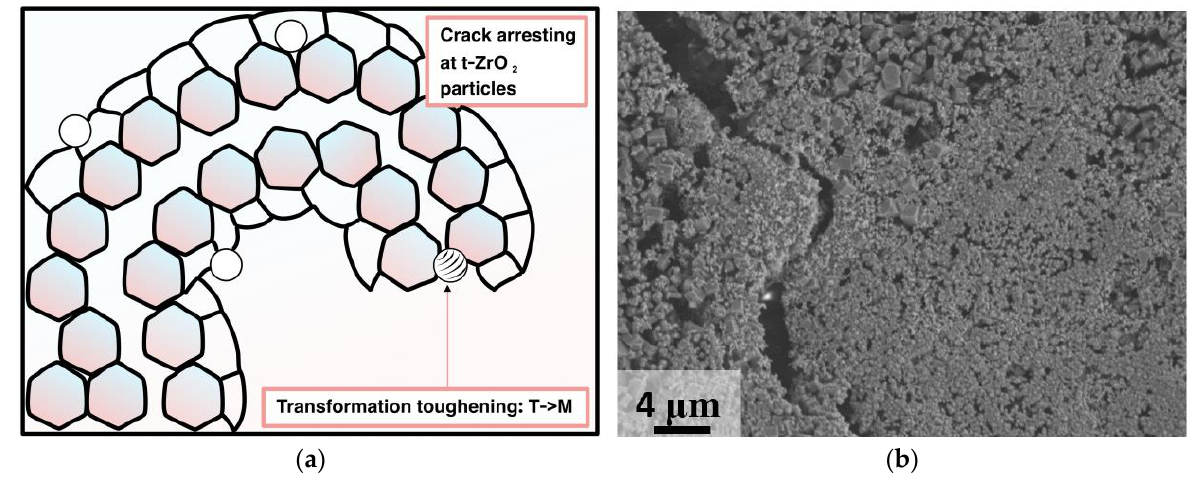
Figure 12. ( a ) Scheme of crack arresting by the ZrO 2 particle; ( b ) SEM image of the fractured Mg20KY-TZP sample.